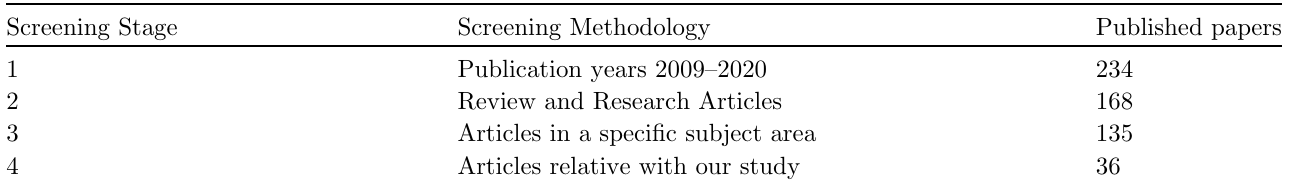
Table 5. Consecutive screening regarding the ‘ sustainable biohydrogen production ’ bibliographic search. Screening